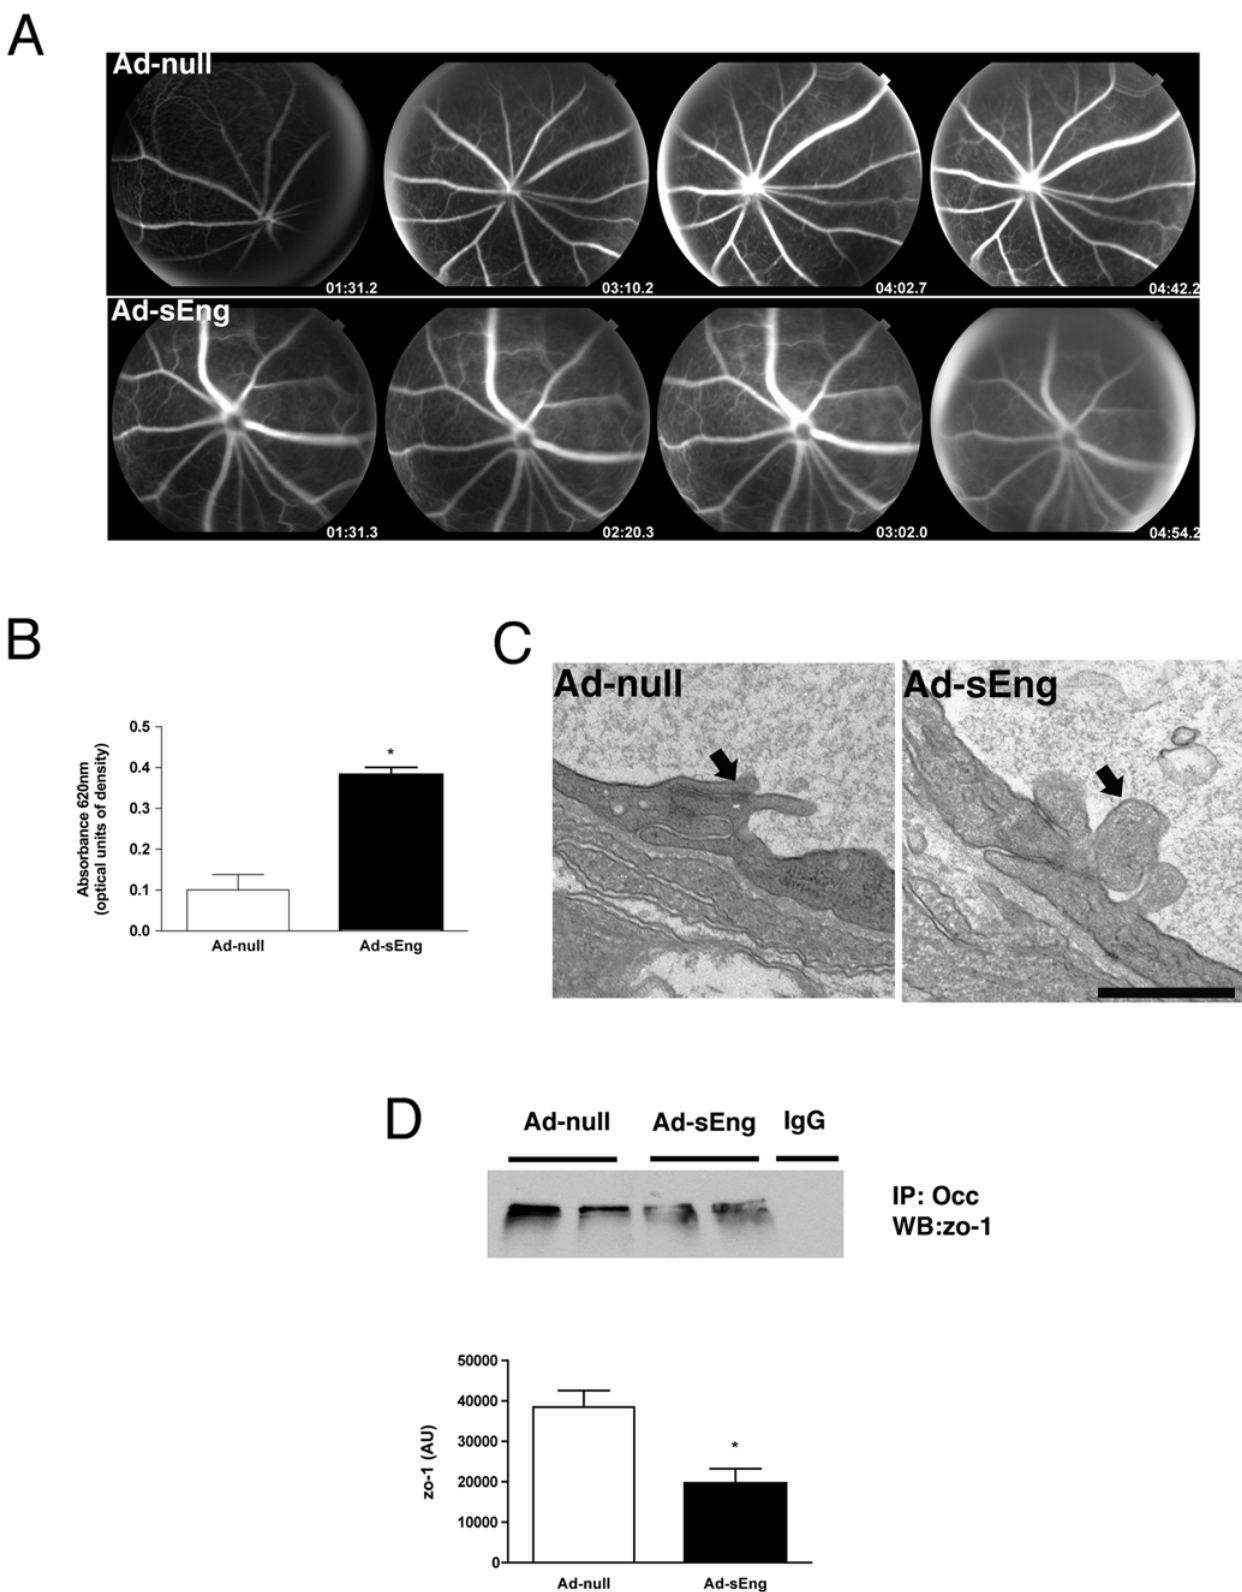
Figure 3. Inhibition of TGF- b decreases endothelial barrier function in vivo. (A) Fluorescein angiography of the retina was performed seven days following adenovirus injection. Ad-sEng-expressing mice displayed increased retinal permeability compared to control mice. The increased fluorescence leakage into the vitreous was observable at two min. Representative photographs are shown (n=4). (B) Experimental mice infected for